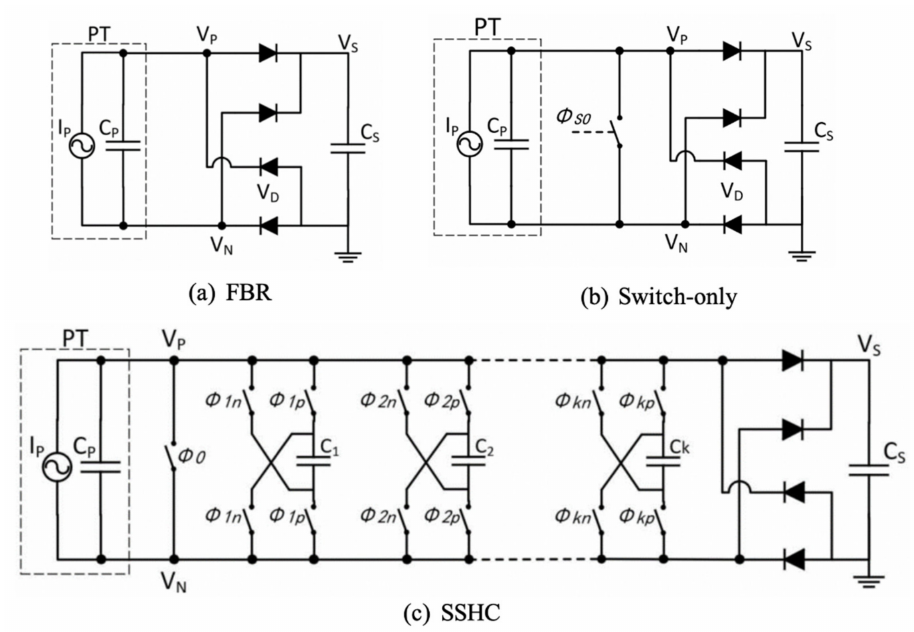
Figure 10. ( a ) Circuit diagram of an FBR, ( b ) a SO rectifier and ( c ) an SSHC rectifier.